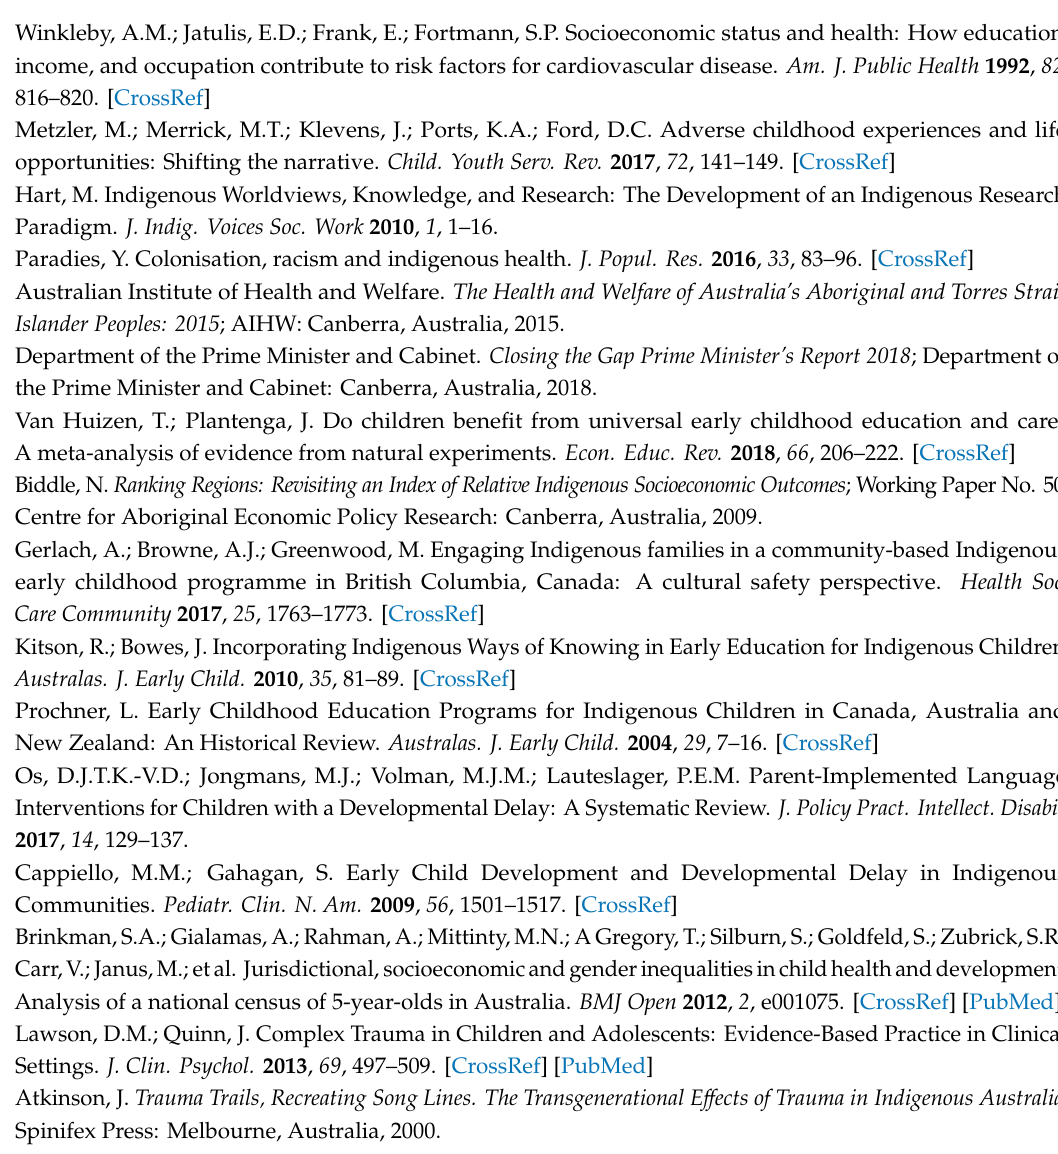
Table S1: Search strategy, Table S2: CASP